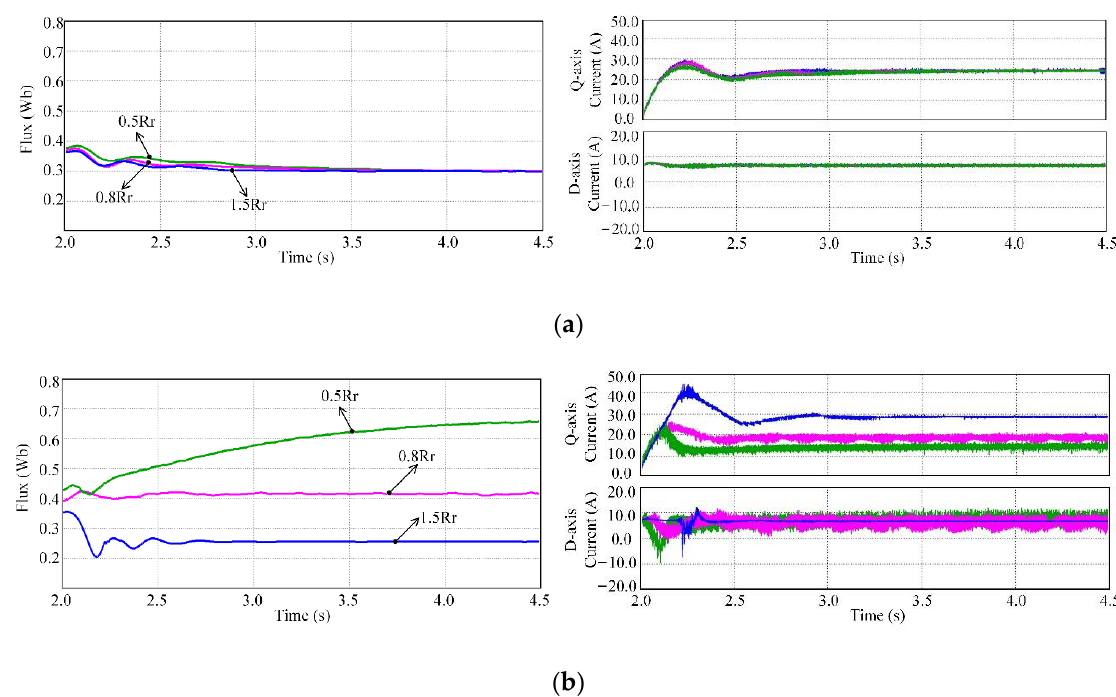
Figure 8. Rotor flux, q-axis current, and d-axis current comparative waveforms at 3000 rpm with a 20 Nm load at 2.0 s. ( a ) Rotor flux and d/q current with compensation; ( b ) Rotor flux and d/q current without compensation.